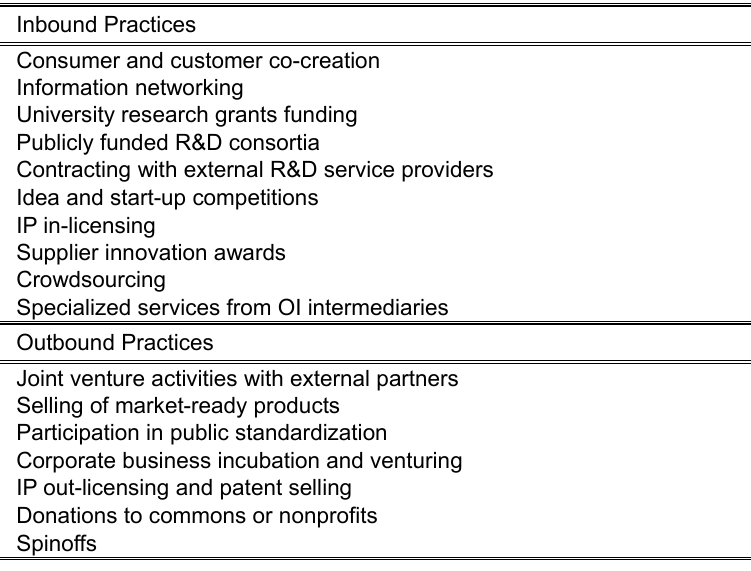
Table 2. OIP in Chesbrough and Brunswicker (2014) Inbound